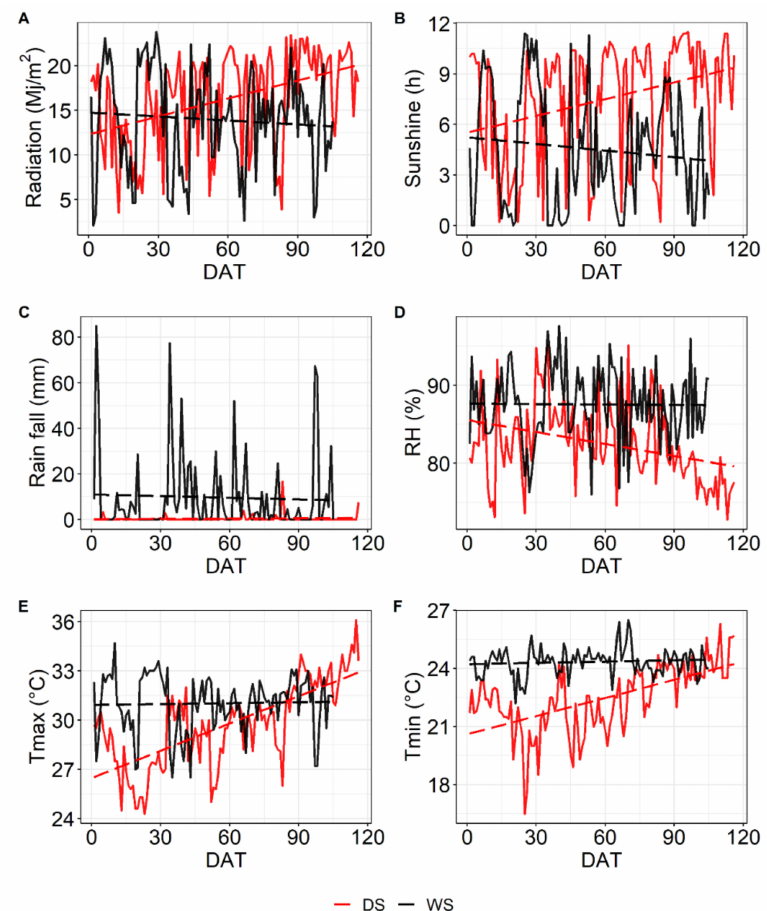
Figure A2. Weather data for the DS and WS experiment measured at the IRRI weather station as average values per day. Radiation ( A ), sunshine duration ( B ), rainfall ( C ), relative humidity ( D ), maximal temperature T max ( E ), minimal temperature T min ( F ). Broken lines represent a trend line for the respective data set. DAT—days after transplanting. Average values for all weather parameters were significantly di ff erent ( p < 0.05) between WS and DS.